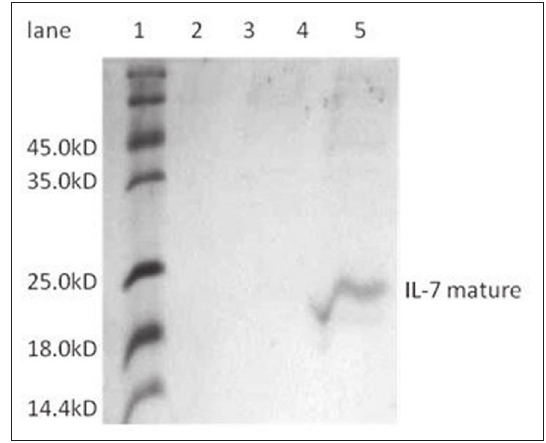
Figure-2: Polyacrylamide gel electrophoresis analysis of purified bovine interleukin 7 mature (bIL-7 mat) protein purified by nickel-nitrilotriacetate (Ni-NTA) chromatography. pET28a expressed bIL-7 mat protein was purified by Ni-NTA chromatography. After loading the protein, column was washed with reducing concentrations of urea in wash buffer and eluted with 250 mM imidazole. Different fractions of elute loaded for checking the presence of protein. Lane 1: Molecular weight protein markers, Lane 2, 3, 4, 5: Differentelutes of Ni-NTA chromatography.